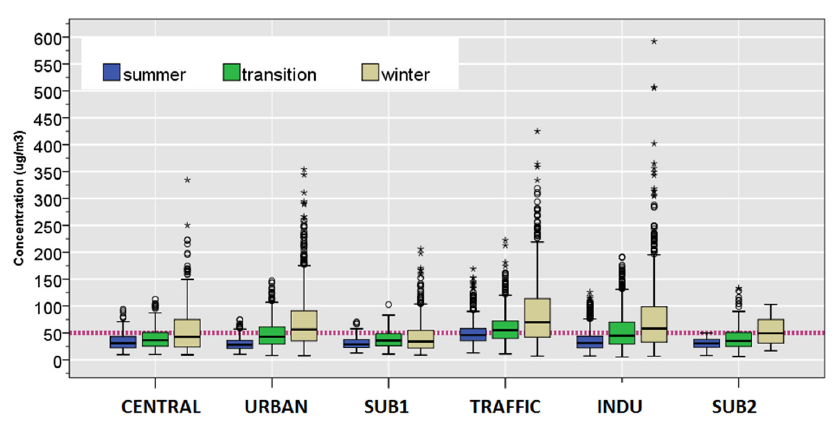
Figure 2. Distributions of daily concentrations of PM 10 during summer (June, July, and August); transition (April, May, September, and October); winter (November through March). The dotted line shows the EU standard of 50 µg/m 3 for PM 10 . Boxes show 25th, 50th and 75th percentile; the whiskers show 5th and the 95th percentile values. The symbols, ○ and * , represent measurements that are >1.5- and >3-fold of the interquartile